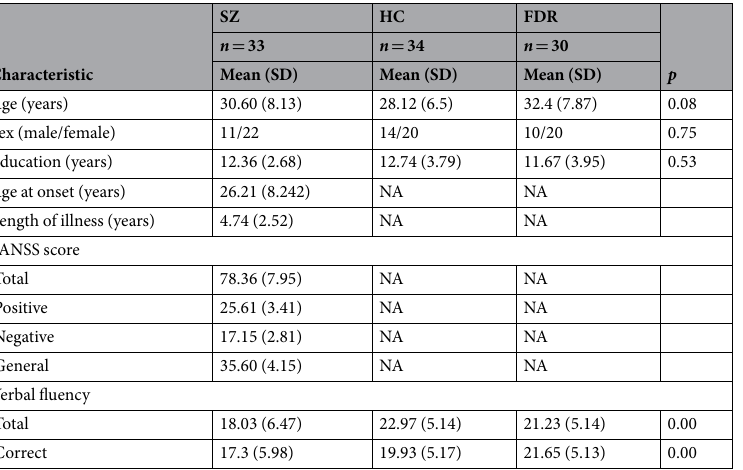
Table 1. Demographic and clinical characteristics of the participants in each group. SZ, schizophrenia patients; FDR, first-degree relatives; HC, healthy